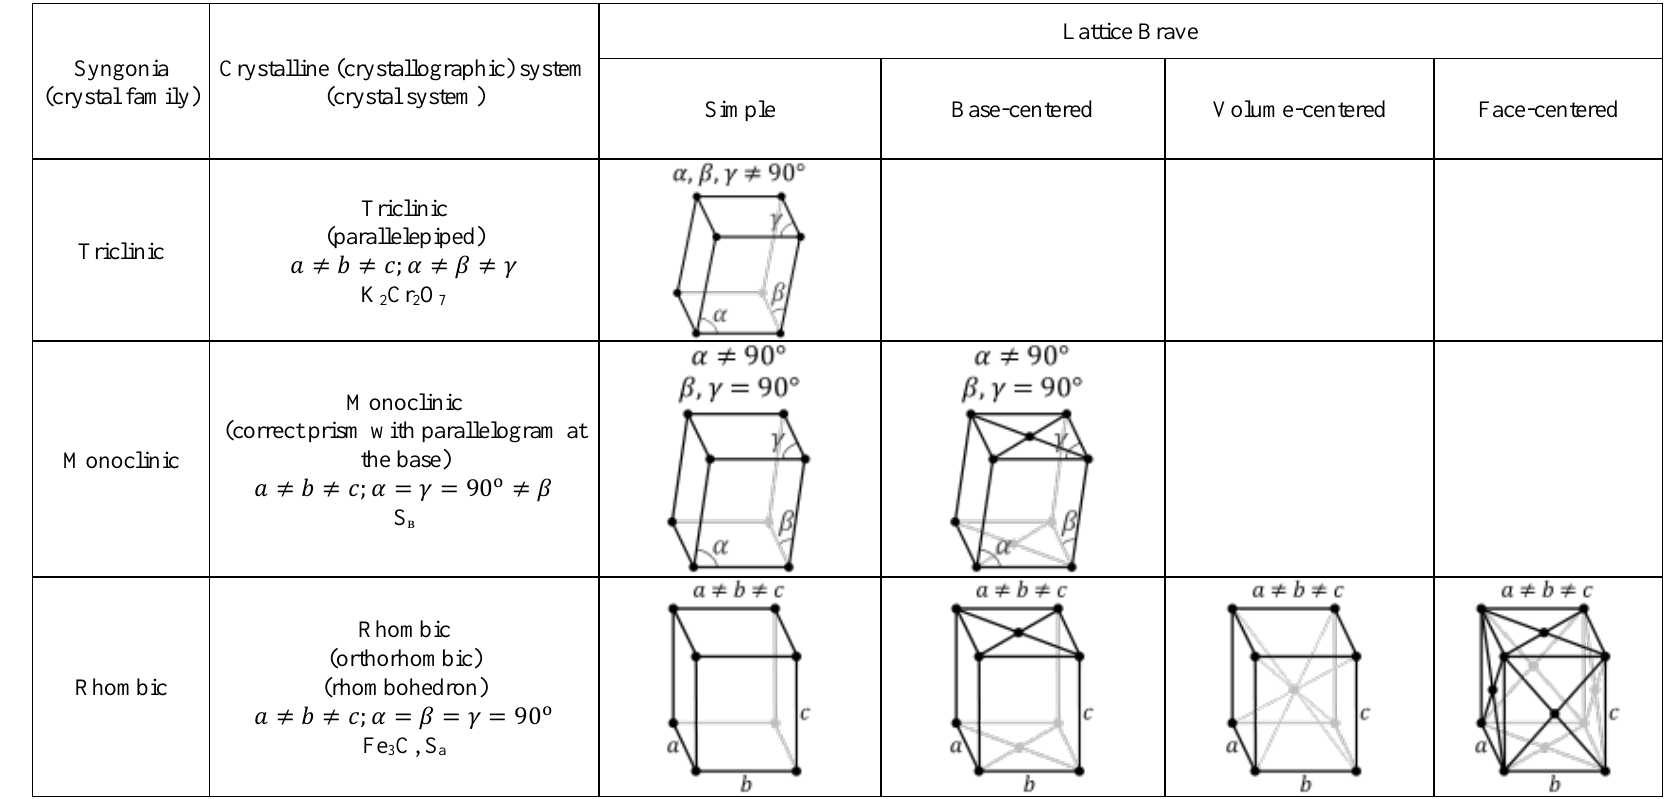
Table 1. Types of syngonias and crystalline systems for three dimensions.